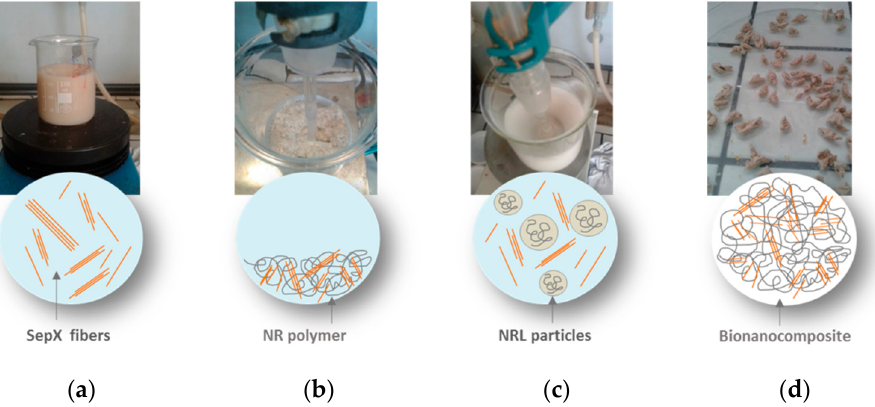
Figure 1. Scheme of the sepiolite/natural rubber (SepX/NR, with X = S9, B5) biocomposites preparation: ( a ) Sep dispersion in water; ( b ) mixing of the Sep aqueous dispersion with natural rubber latex (NRL); ( c ) flocculated SepX/NR biocomposite; and ( d ) dried SepX/NR biocomposite pieces.